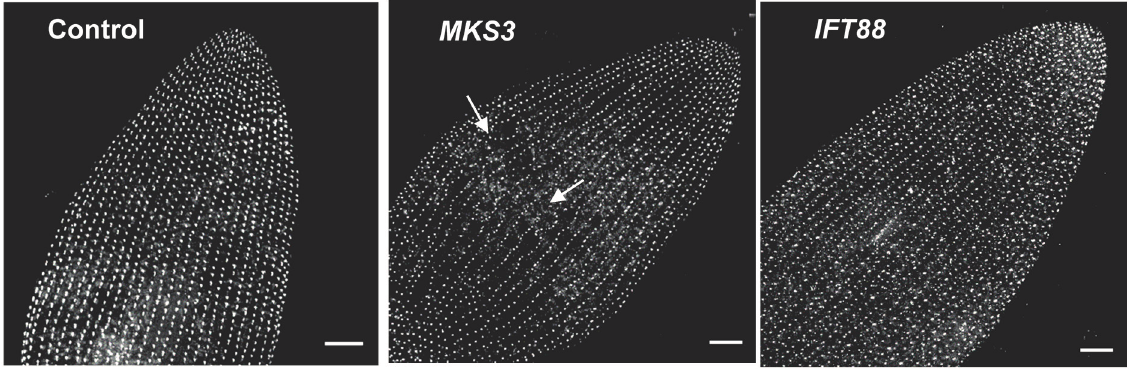
Figure 5. Cells were stained using anti-centrin to visualize the basal bodies. Images represent stacks of Z sections, approximately 10 µm thick. The images shown are the dorsal surface of the anterior end of the cell. Basal bodies should be arranged in organized rows, as seen in the control and IFT88 depleted cells. These latter cells are controls for the effects of shortened and lost cilia because they are depleted in a protein that is important for the import of proteins into the cilia. The MKS3 depleted cell (center panel) shows the basal bodies not aligned and no longer in straight rows (white arrows) at the midline of the cell. Scale bars: 10 µm. With permission from Cilia